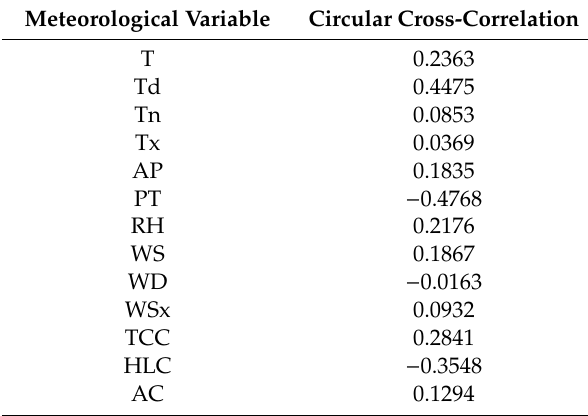
Table 4. Selected meteorological variables and the circular cross-correlation